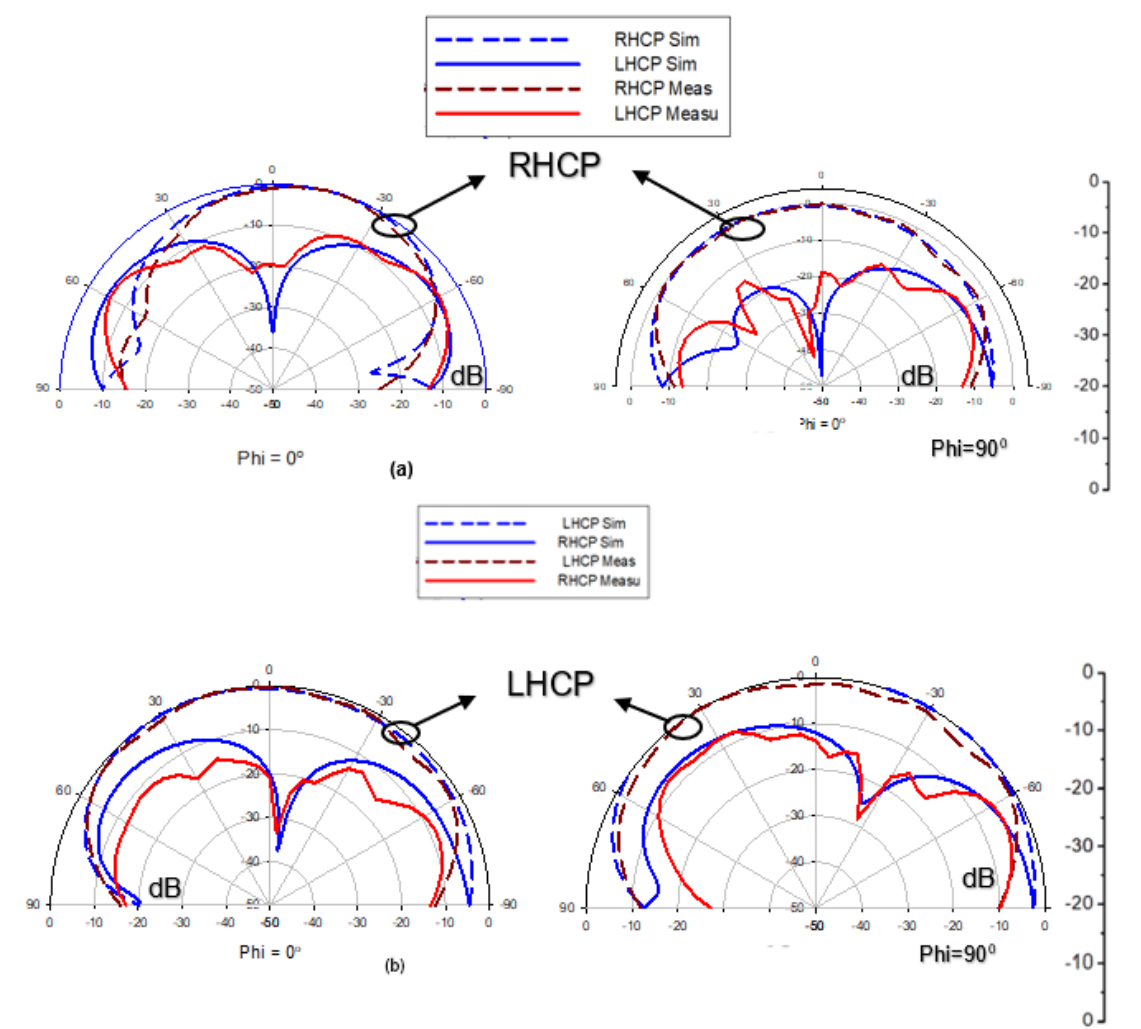
Figure 13. Radiation pattern of the rectangular DRA at 3.47 GHz and 4.41 GHz at Phi = 0° and phi = 90°.